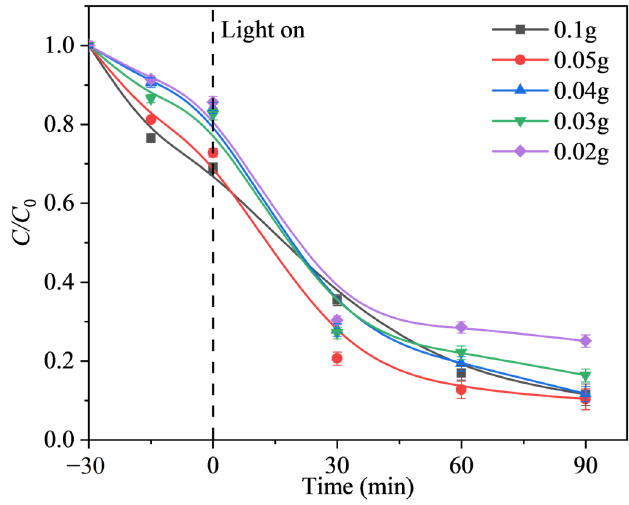
Figure 6. Effect of dosage on photocatalytic efficiency (3 replicates; pH = 4; C 0(TCH) = 10 mg/L).